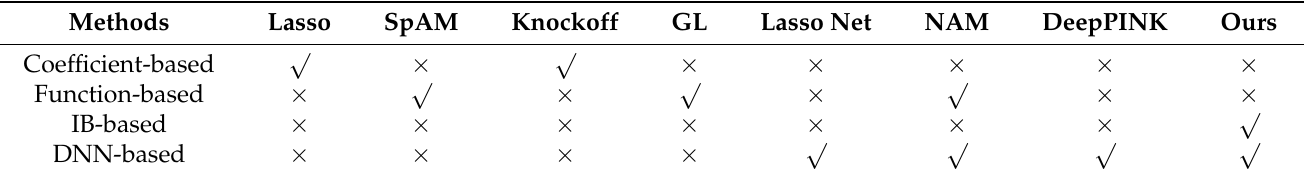
√ means satisfying the given information, and × means